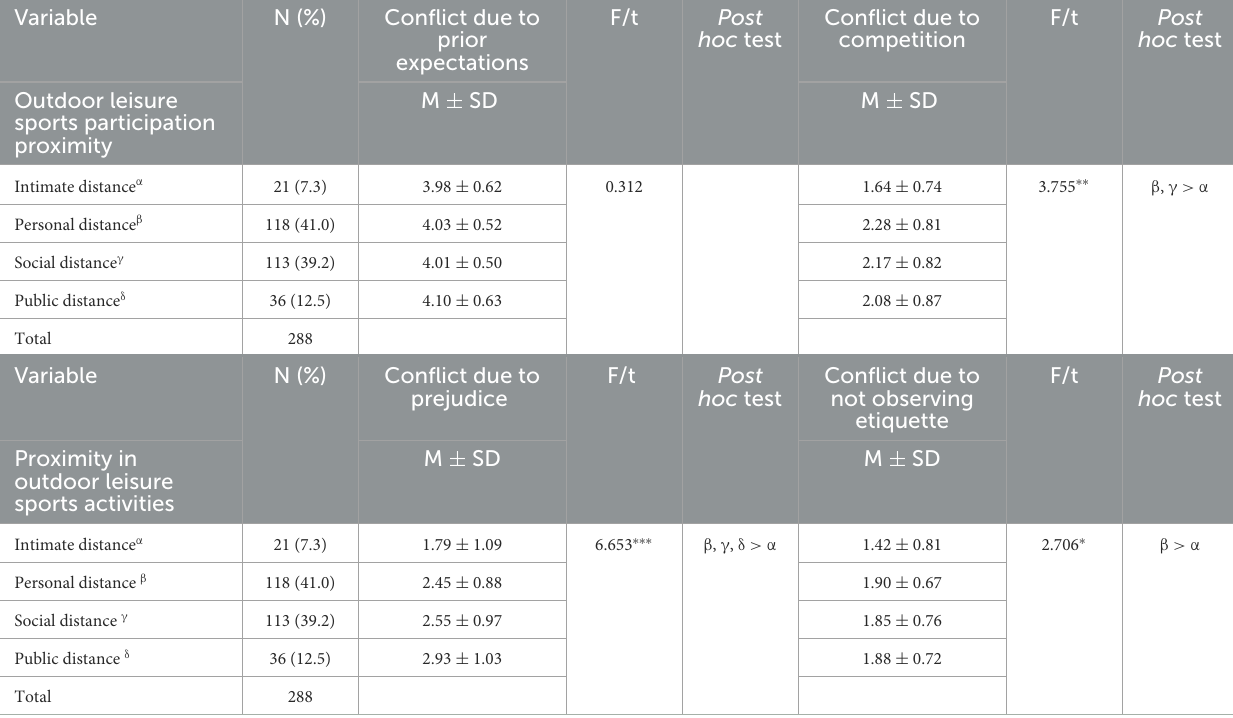
TABLE 4 Differences in leisure conflicts depending on spatial proximity among outdoor leisure sports ( N = 288). Variable N (%) Conflict due to prior